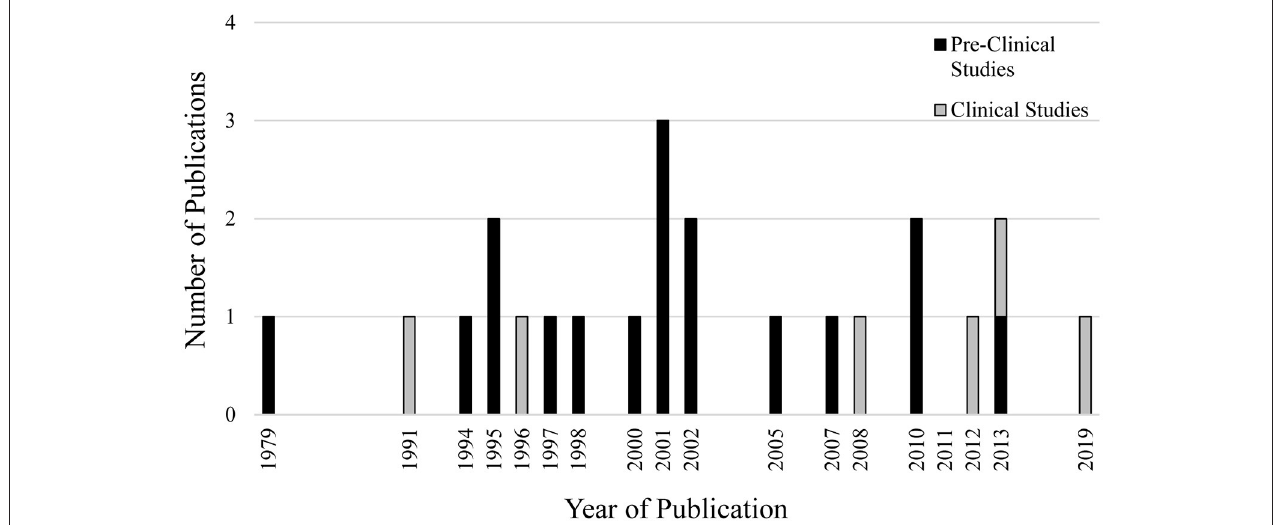
FIGURE 2 | Number of publications per year related to experimentally-induced pain/noxious stimulation and muscle spindle afferent